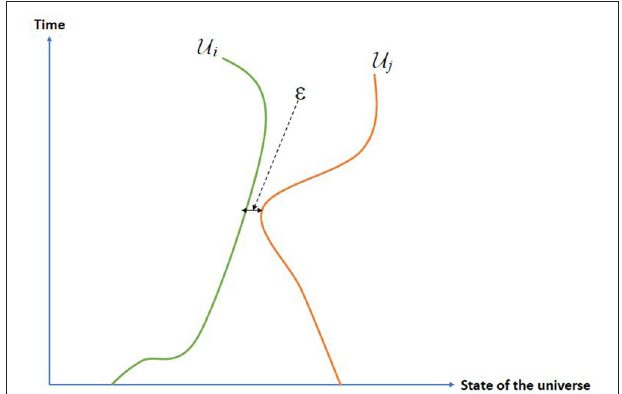
FIGURE 1 | Two “close” universes at present time were most likely “far” in the past.